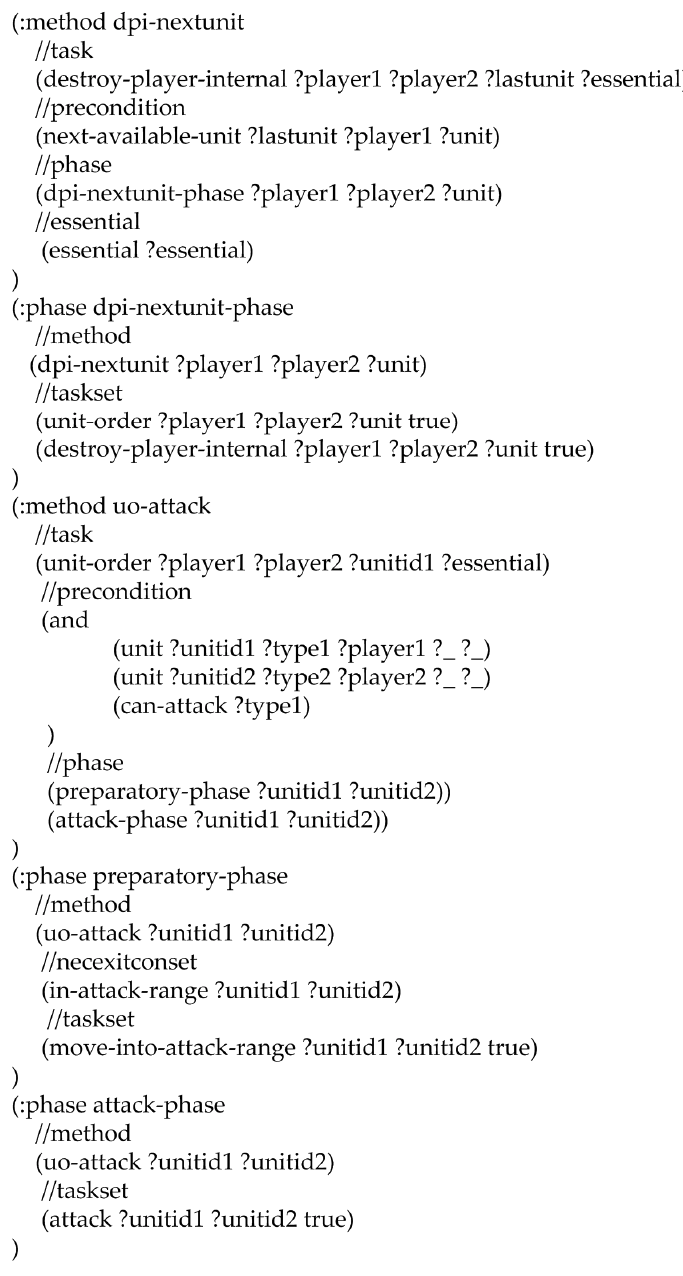
Figure 6. An example of the AHTN-R process of executing the compound task destroy-player-internal from the Low-Level functionality. from the Low-Level